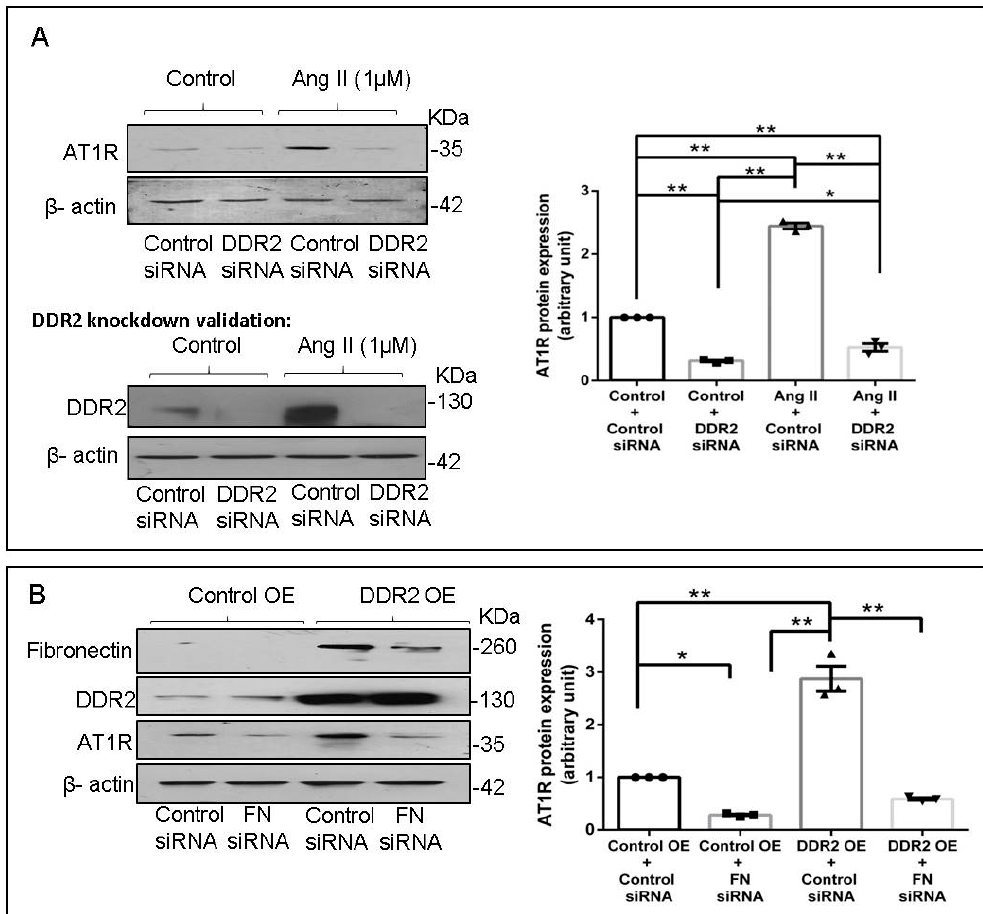
Figure 5. DDR2 regulates Ang II-stimulated protein expression of AT1R in cardiac fibroblasts. ( A ) Cardiac fibroblasts were transiently transfected with DDR2 siRNA (5 pmol) or control (scrambled) siRNA prior to treatment with Ang II for 12 h. AT1R protein expression was examined, with β -actin as loading control. Validation of DDR2 silencing is also shown. * p < 0.05, ** p < 0.01 (comparisons as depicted in the Figure). ( B ) Cardiac fibroblasts were co-transfected with fibronectin siRNA (10 pmol) and DDR2 cDNA overexpression plasmid (2 µg). Following transfection, the cells were revived in M199 with 10% serum for 12 h. Post-revival, the cells were serum-deprived for 24 h prior to treatment with Ang II for 12 h. Cells were collected, and AT1R protein levels were examined, with β -actin as loading control. * p < 0.05 and ** p < 0.01 (comparisons as depicted in the Figure). Validation of fibronectin knockdown and DDR2 overexpression is also shown. Data are representative of three independent experiments, n = 3, Mean ± SEM.